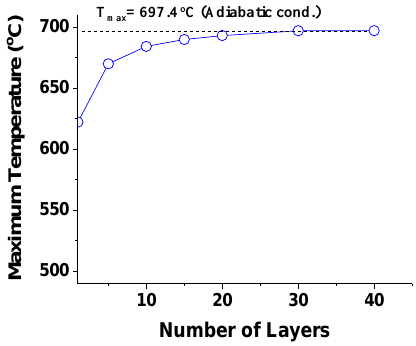
Figure 4. Maximum cell temperature as a function of the number of stacked unit cells.